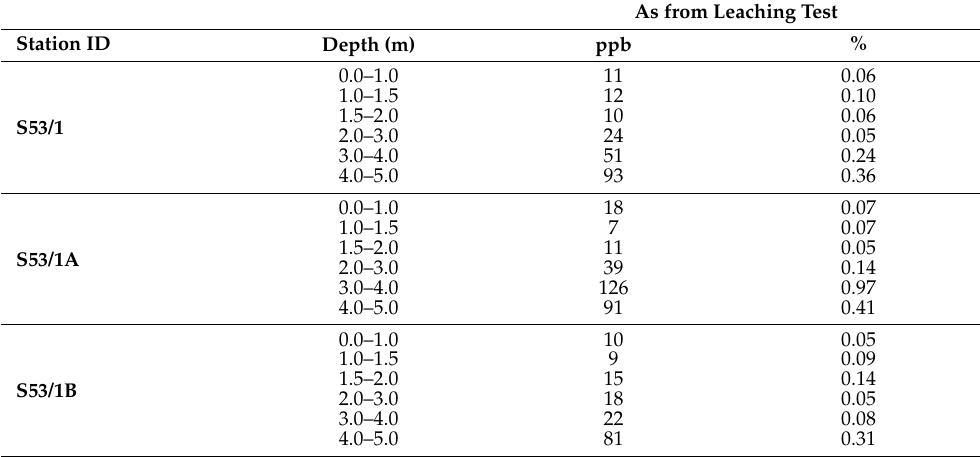
Table 6. Leaching test data for As in the soil samples coming from the 5 cores of point S53, and its close surroundings. The values are reported in ppb ( µ g/kg dry weight) and as a percentage of the total extracted